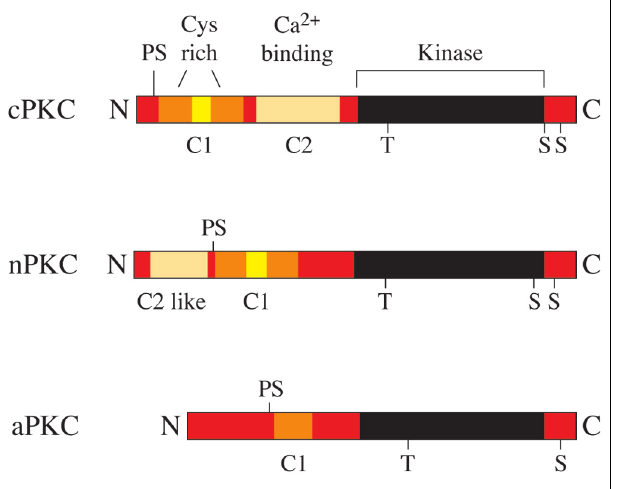
FIGURE 1 |The human PKC gene family. PKC proteins are classified into conventional PKCs (cPKC; α , β , and γ ), novel PKCs (nPKC; ε , δ , θ , and η ) and atypical PKCs (aPKC; ζ and ι ). cPKCs require Ca 2 + and diacylglycerol (DAG) for activation, nPKCs are Ca 2 + independent and aPKCs require neither Ca 2 + nor DAG for activation.